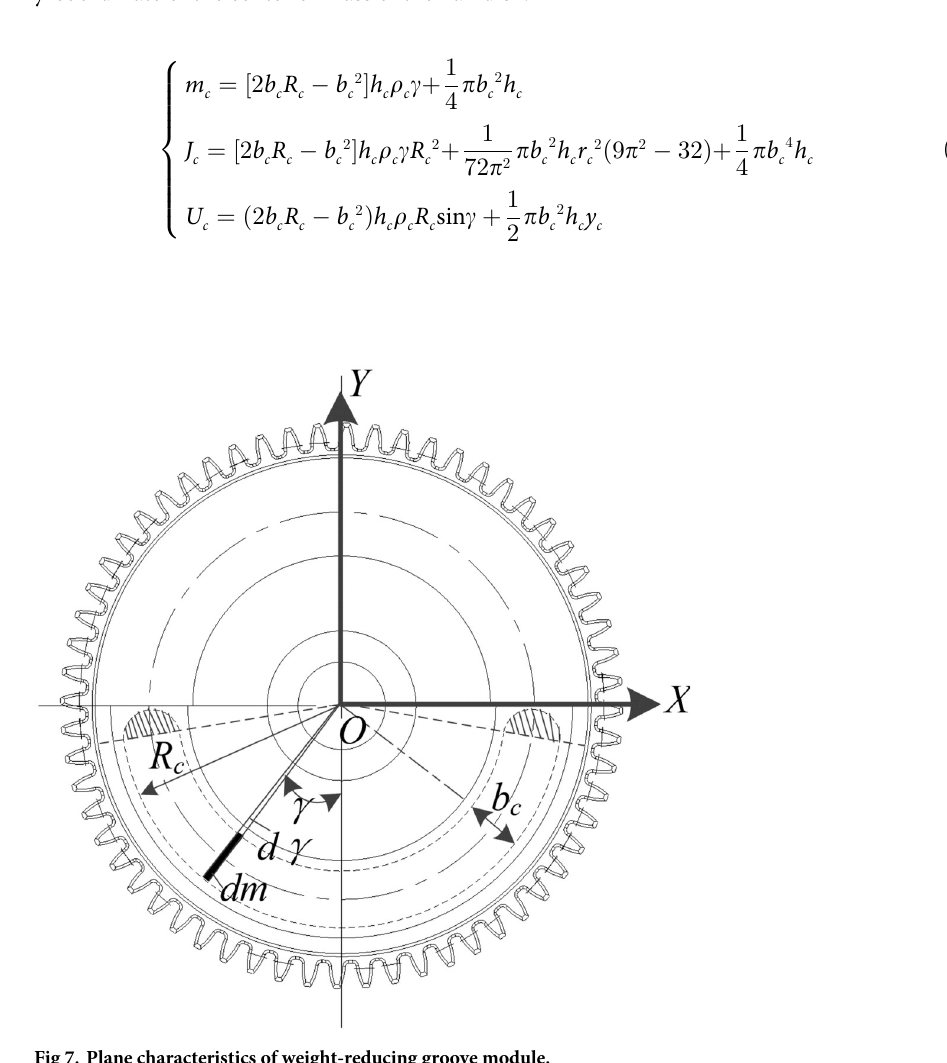
Fig 7. Plane characteristics of weight-reducing groove